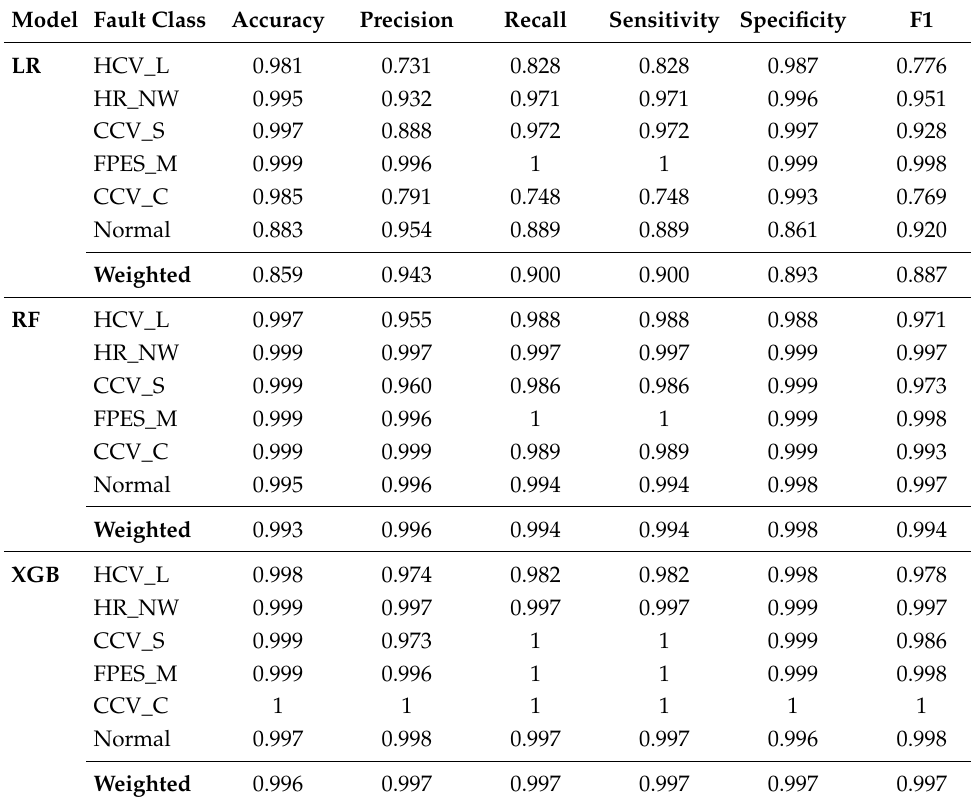
Table 5. Performance matrix of the used models in the fault diagnosis task. Model Fault